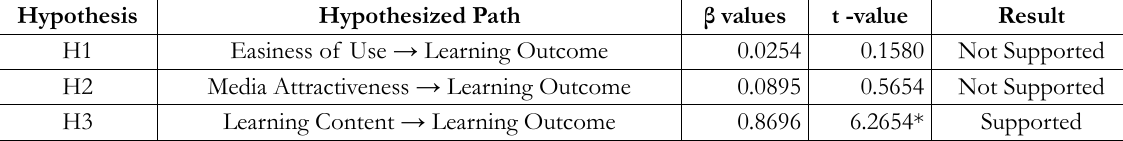
Table 6. Hypothesized